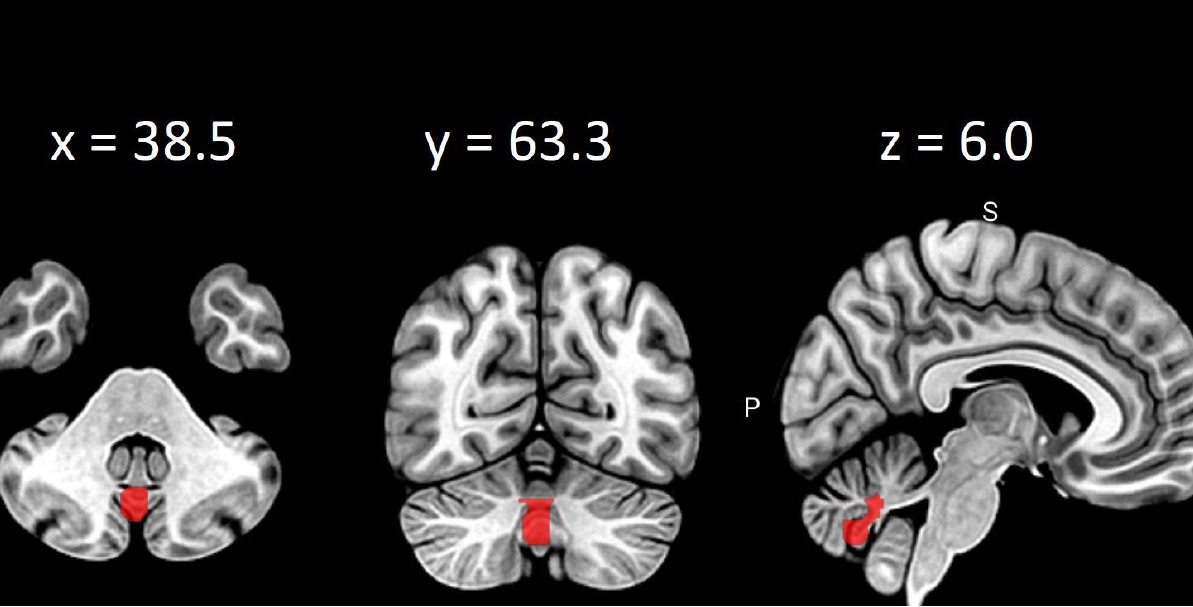
Figure 3. Clustering coefficient differences in vermis VIII on thresholds: 0.2, 0.25, 0.30 and 0.35.